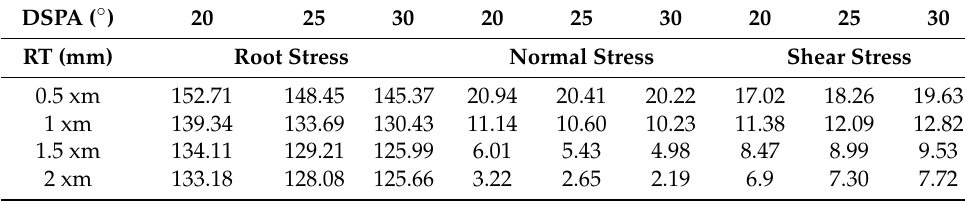
Table 6. Root stress (N/mm 2 ) results of hybrid gears for different DSPAs and